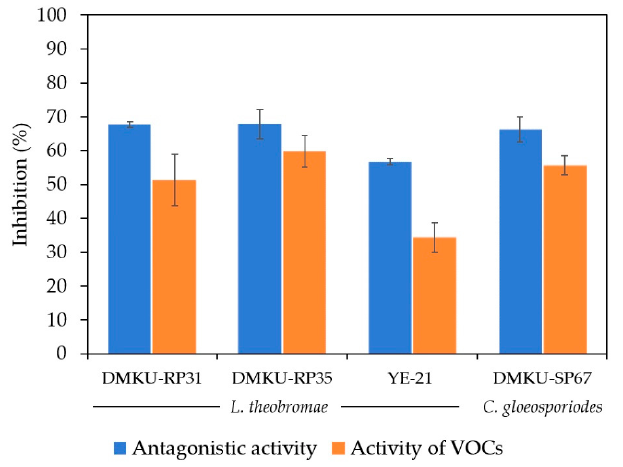
Figure 3. Inhibition of L. theobromae and C. gloeosporiodes growth on PDA plates at 25 °C for 3 and 14 days, respectively, by antagonistic yeast strains using dual cultivation and VOCs produced by antagonistic yeast strains using double plates.